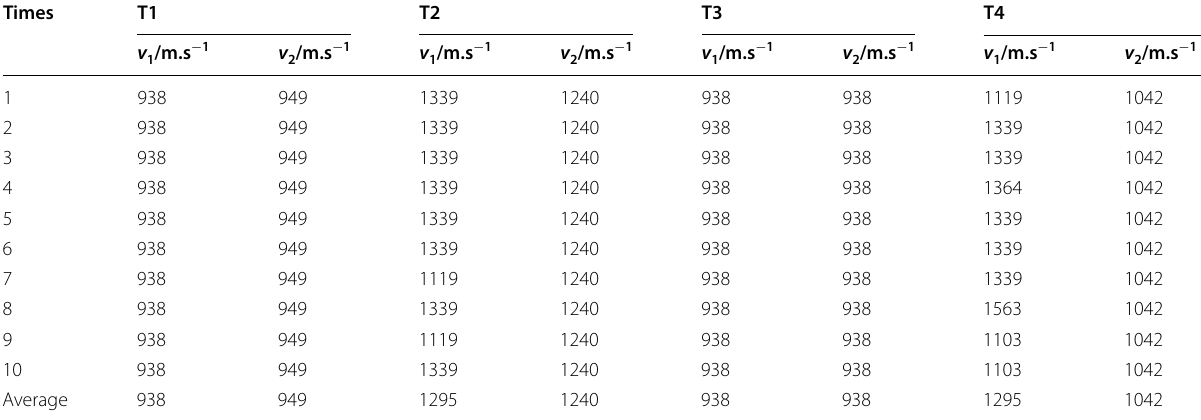
Ten independent tests were carried out on four specimens, where v 1 and v 2 denote the propagation velocity at a distance of 150 mm and 300 mm, respectively, the test results are shown in Table 1.